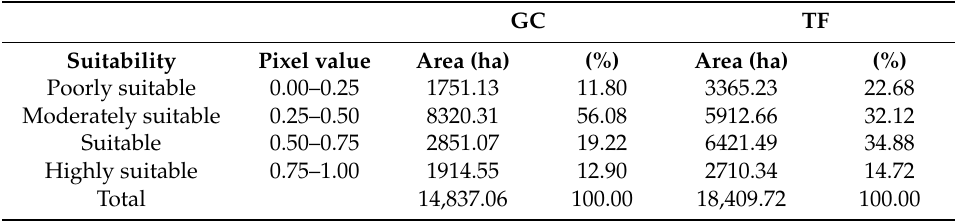
Figure 5. Available territorial resource map (ATRM) for the wind energy sector of Gran Canaria and Tenerife. Table 2. Suitability levels of land for wind farm